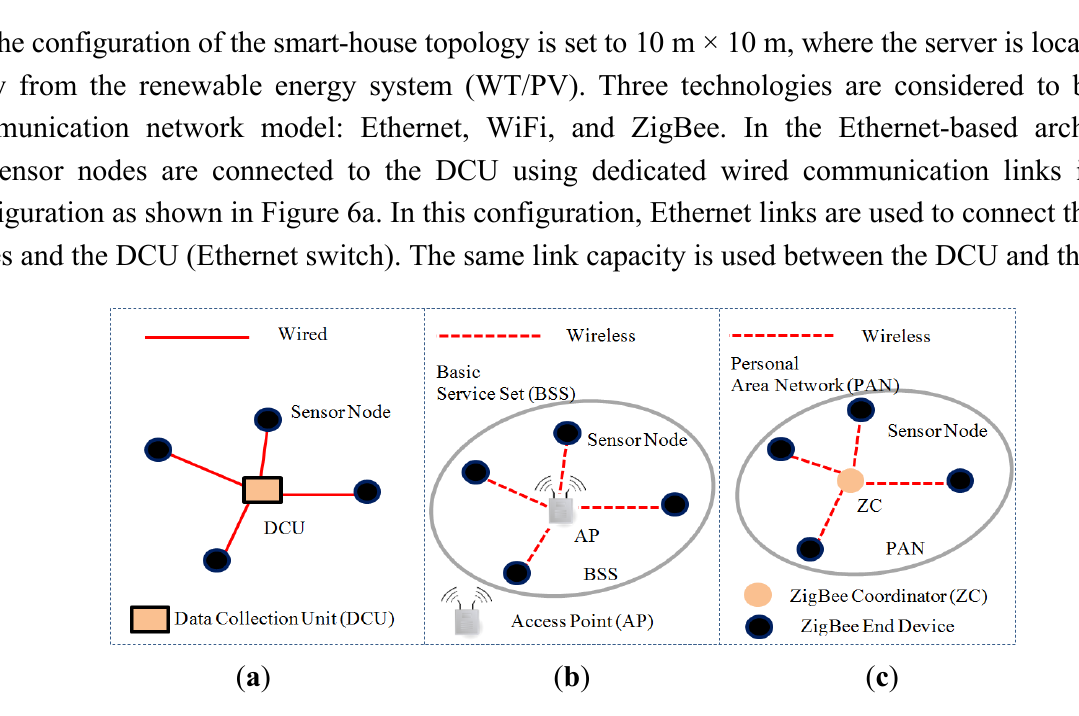
Figure 6. ( a ) Ethernet star network architecture; ( b ) WiFi infrastructure mode architecture; ( c ) ZigBee star network